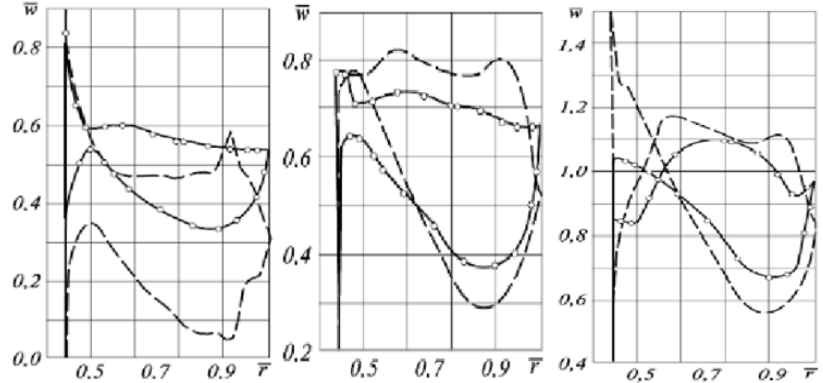
Figure 3. Velocity diagrams on the impeller blades. On the ( left ) is an incidence angle i 0 , in the ( middle ) is non-incidence flow (i = 0), on the ( right ) is a negative incidence angle (i < 0). Solid lines—measurement, dashed lines—inviscid quasi-three-dimensional calculation (average current surface) [25].